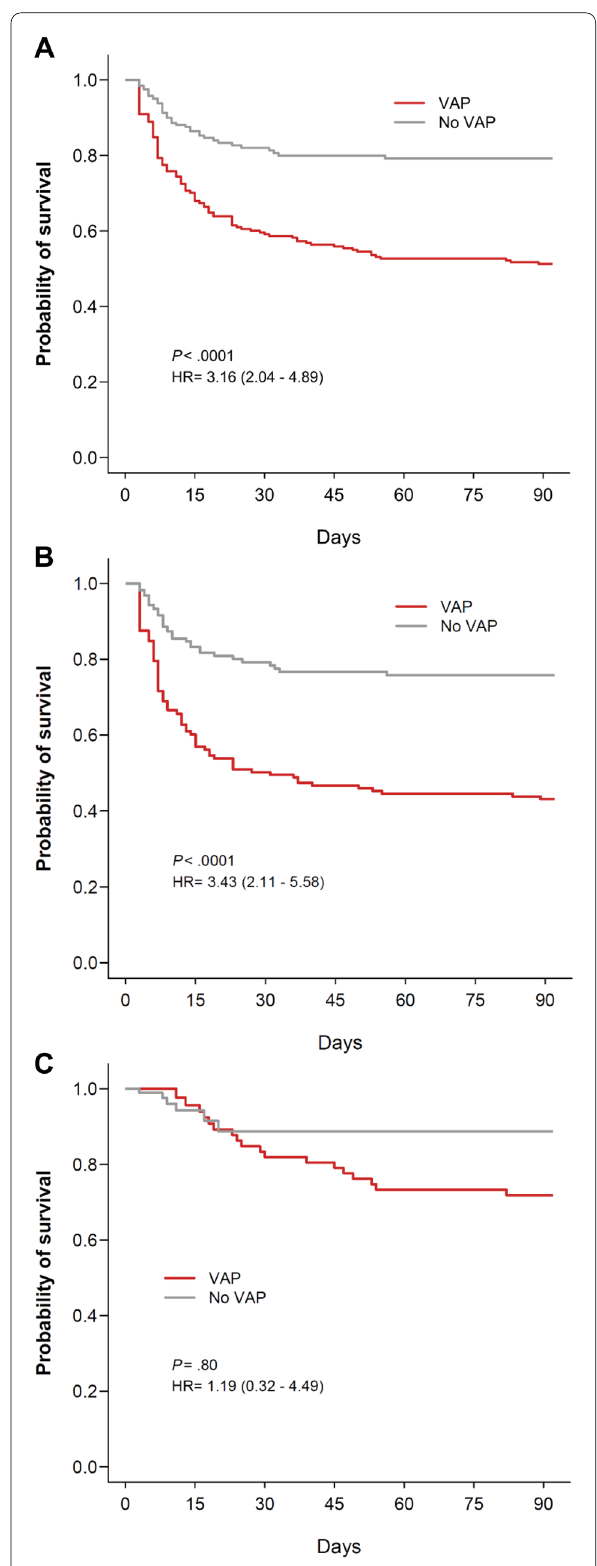
Fig. 1 Cumulative likelihood of survival over time in patients with and without VAP. VAP ventilator-associated pneumonia, HR hazard ratio (indicated with 95% confidence interval). Day 0 indicates the date of intubation. Panel A , all patients with acute respiratory distress syndrome (ARDS); Panel B , patients with non-coronavirus disease 2019 (COVID-19)-related ARDS; Panel C , patients with COVID-19-related ARDS